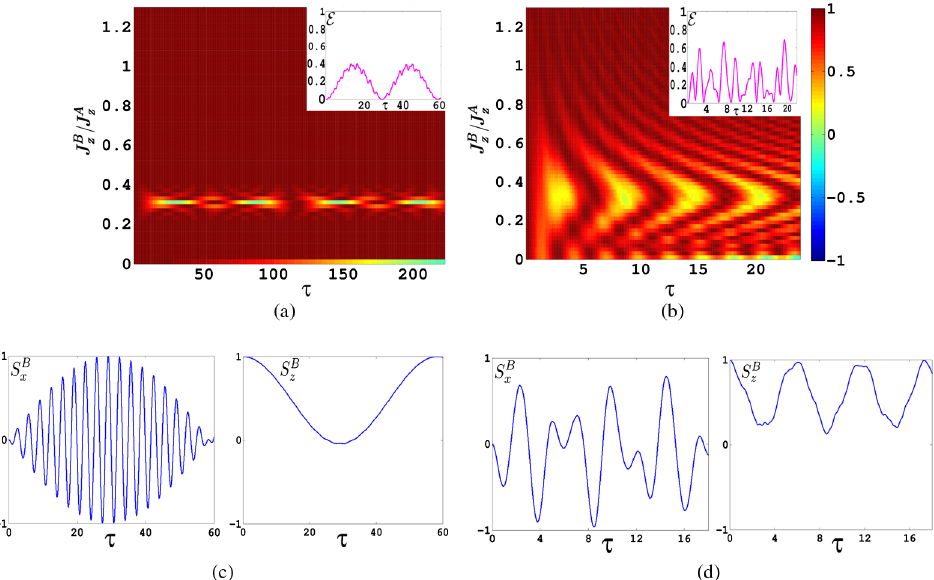
FIG. 4 (color online). Rabi nutation of two coupled qubits in the geometry of Fig. 1(c). Qubit A is driven at its level splitting J A z with a Rabi frequency ϵ ¼ 0 . 3 J A z , and qubit B is coupled to A with a coupling constant J AB . Time τ is in periods of the free precession of A . The color scale in (a) and (b) is the value of the Rabi nutation of S B between − 1 and 1 . (a) J AB ¼ 0 . 01 J A z . Inset: Entanglement E vs τ for J B ¼ 0 . 3 J A J ¼ 0 . 1 J A z z . (b) z . Inset: Entanglement AB